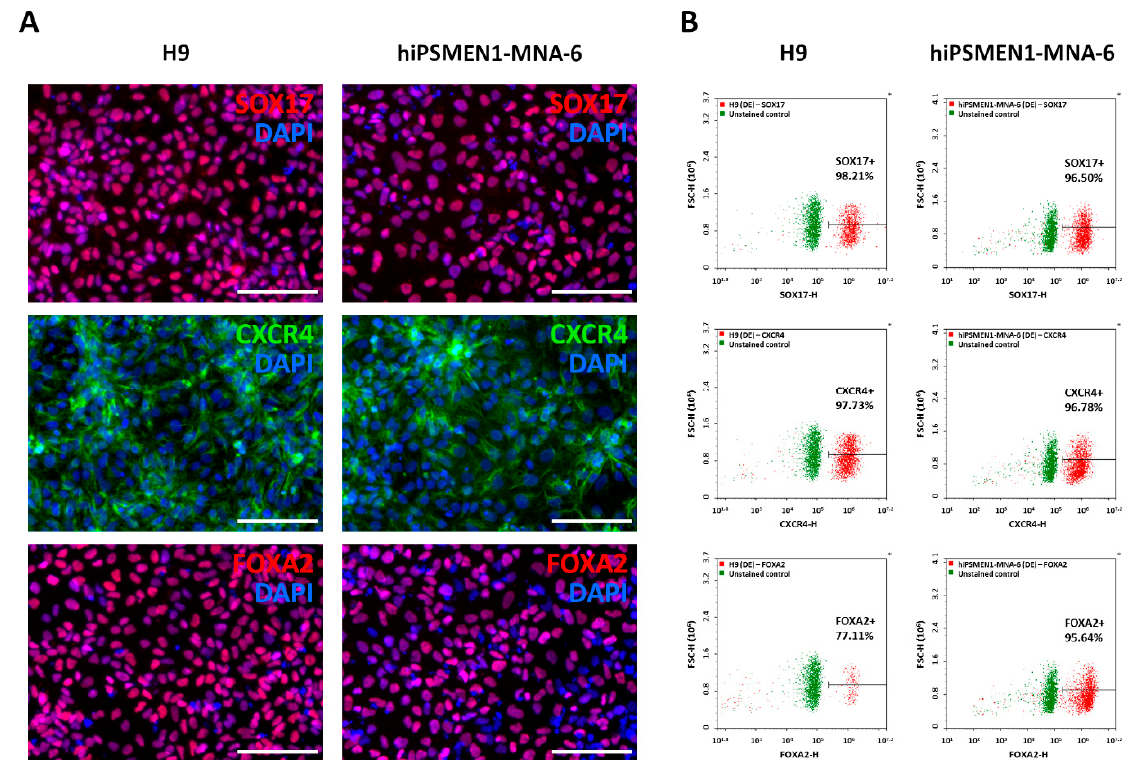
Figure 2. Assessment of the definitive endoderm (DE) differentiation potential of the established patient-derived hiPS- MEN1-MNA-6 cells in comparison to the human embryonic stem cell line H9 (gold-standard). ( A ) Immunostaining for DE markers SOX17 (red), CXCR4 (green), and FOXA2 (red). DAPI was used to counterstain cell nuclei (blue). Scale bars represent 100 μ m; ( B ) Flow cytometry analysis for DE markers SOX17, CXCR4, and FOXA2. Data are presented as dot plots of forward scatter (FSC) versus DE marker fluorescence (in the FITC fluorescence channel). The horizontal marker was set based on background fluorescence from unstained cells. Populations of SOX17+, CXCR4+, and FOXA2+ cells and unstained cells are shown in red and green, respectively.